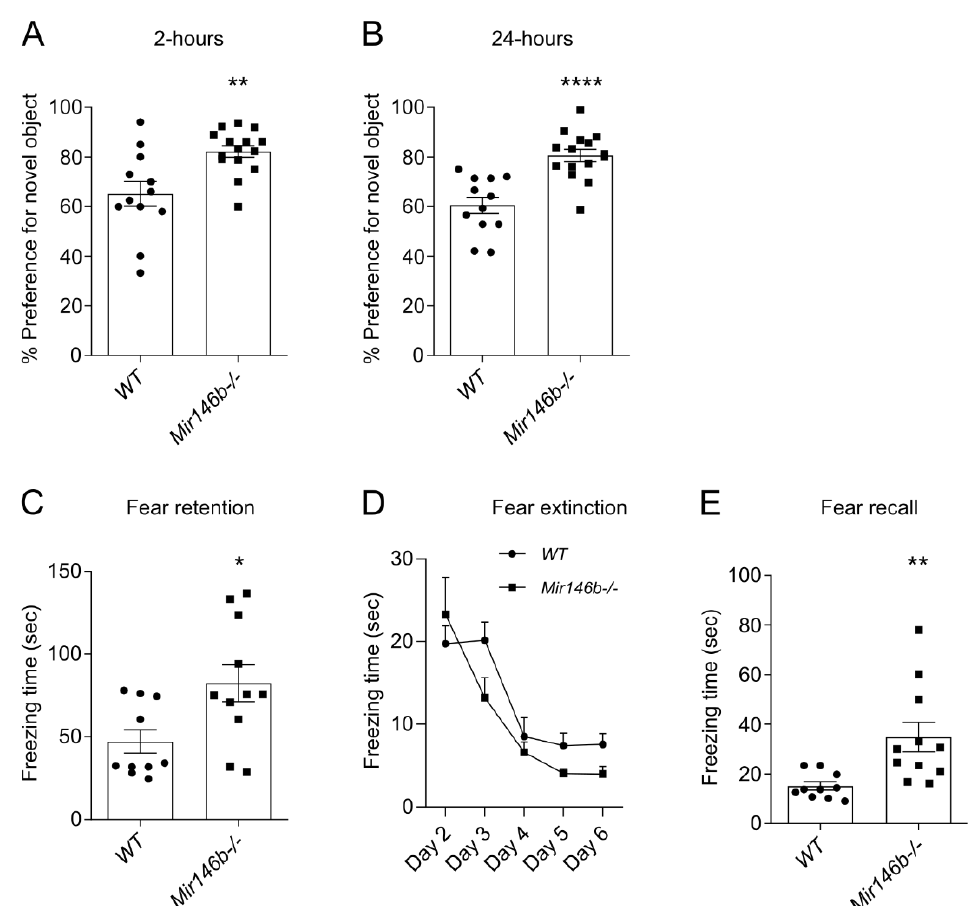
Figure 2. Enhanced recognition and associative memory in Mir146b-/- mice. ( A ) Novel object preference of mice at 2-h (short-term memory) and ( B ) 24-h (long-term memory) in novel object recognition test. ( C ) Contextual fear retention. ( D ) Contextual fear extinction and ( E ) tone fear recall of WT and Mir146b-/- mice in contextual fear conditioning and tone fear recall. Number of animals = 11 – 15 , Student’s t -test and two- way ANOVA followed by Tukey’s multiple comparison test. Data represented as mean ± SEM; * p < 0.05, ** p < 0.01, **** p <0.0001. Next, we assessed the associative memory of Mir146b -/- and WT mice by measuring contextual fear retention and extinction and tone fear recall. There were no differences detected in baseline freezing time between WT and Mir146b -/- mice (Figure S3). The mice retention was measured in the same context. As expected, both WT and Mir146b -/- mice longer freezing time compared to WT mice ( p = 0.0171; Student’s t -test; Figure 2C). Fear extinction was assessed in absence of tone and foot shock from day 2 to day 6 in the same context; however, no differences in genotypes were detected between WT and Mir146b -/- mice (F (1, 95) = 3.117, p = 0.0807; two-way ANOVA; Figure 2D). Nevertheless, while tone fear recall was measured on day 7, Mir146b -/- mice demonstrated significantly longer freezing time compared to the controls ( p = 0.0063; Student’s t -test; Figure 2E). These results indicate that miR-146b deficient mice have better ability to recognize novel objects and have better fear memory acquisition and recall as compared to WT